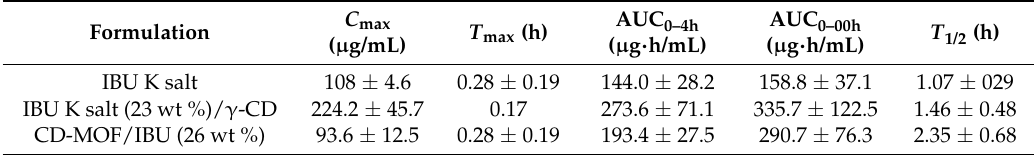
Table 3. Pharmacokinetic data for ibuprofen formulations following oral administration to mice (data reprinted with permission from